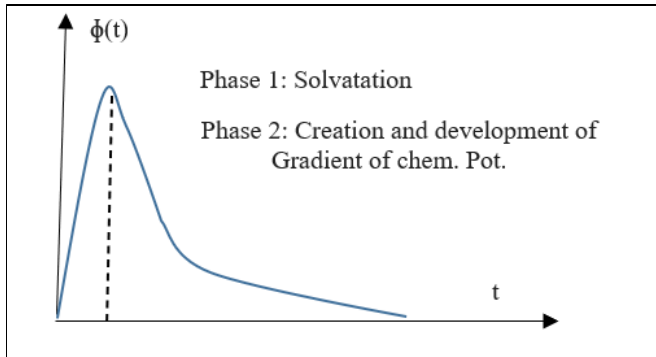
Figure 3: Variation of state Function.